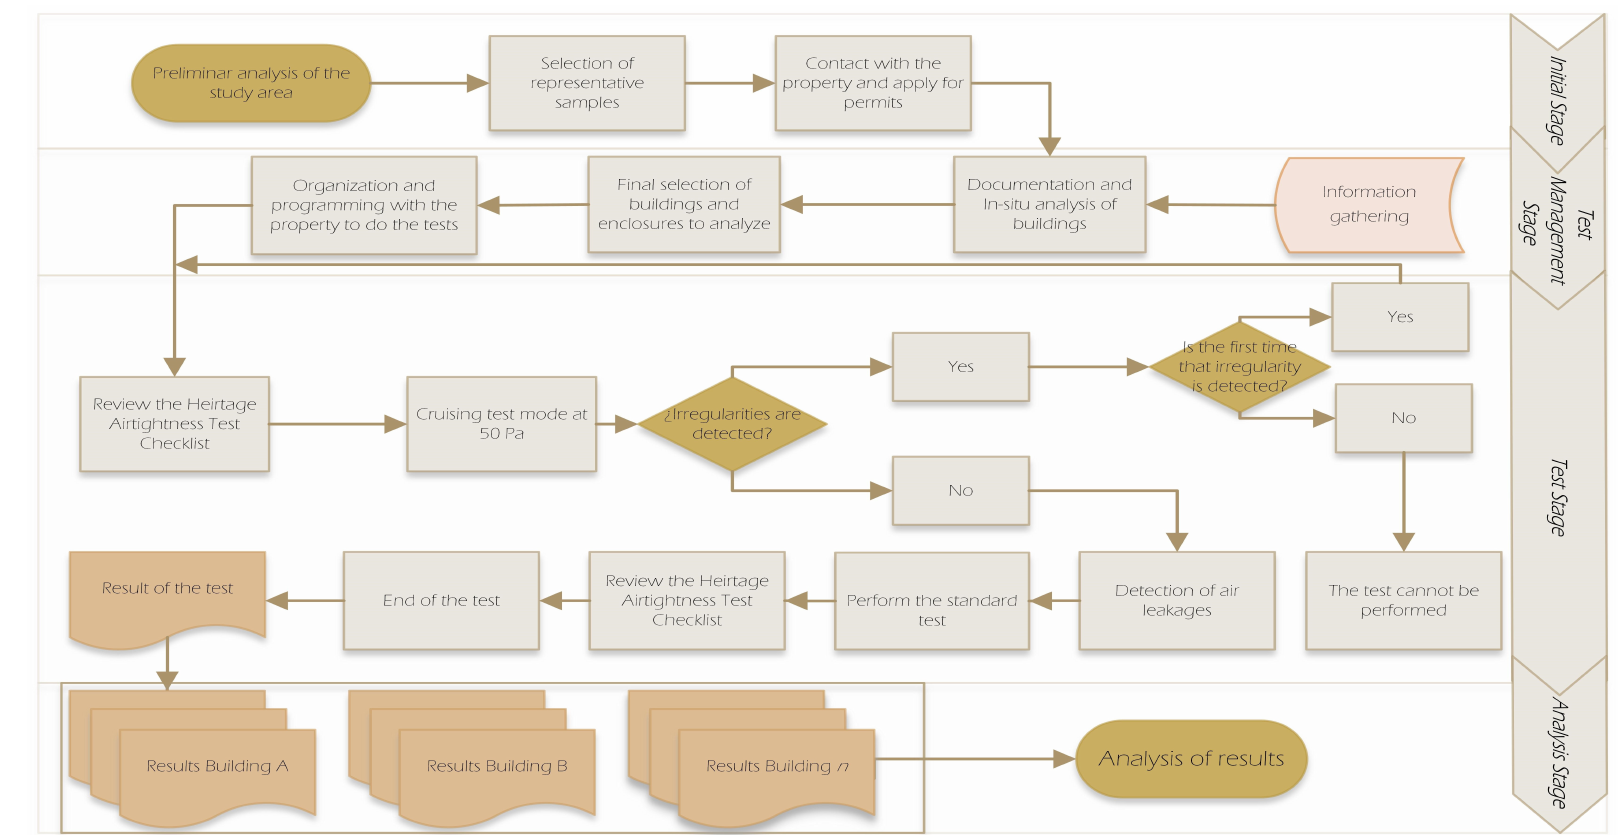
Figure 3. Flowchart of the methodology employed during the